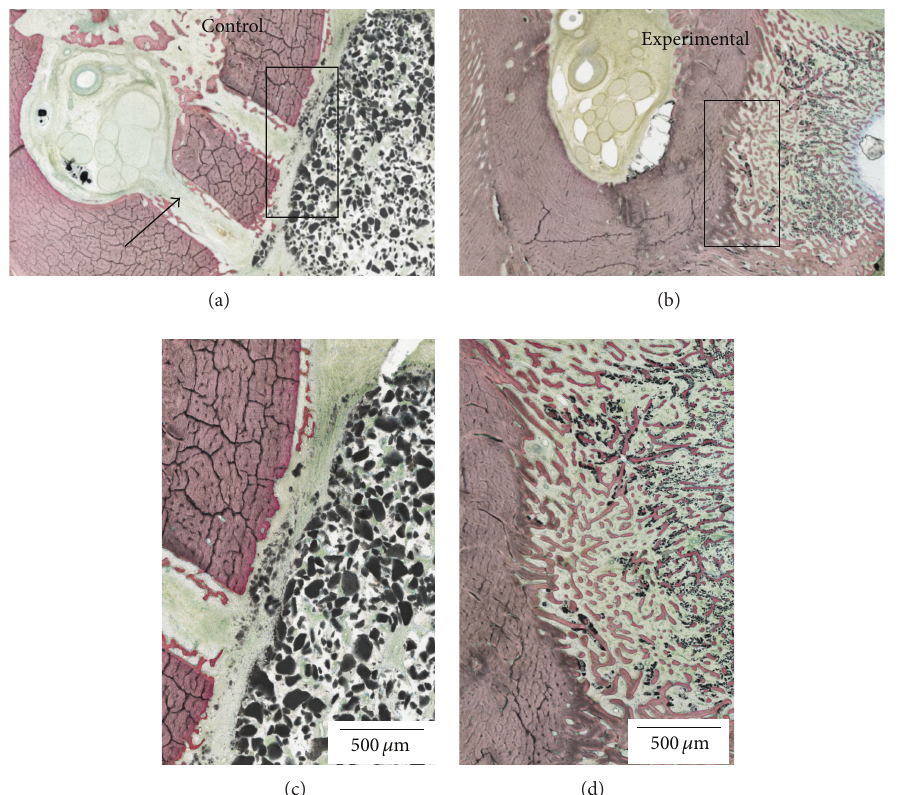
Figure 4: Histologic sections for the (a) control and (b) experimental block materials placed on the lateral aspect of the mandible. The histologic sections revealed the perforations performed in the mandibular lateral aspect cortical (arrows). Higher magnification of the (c) control and (d) experimental blocks showed that bone ingrowth occurred throughout the volume of the experimental block material, and little ingrowth occurred for the control block material. Smaller amounts of synthetic material were also observed for the experimental block relative to the control block